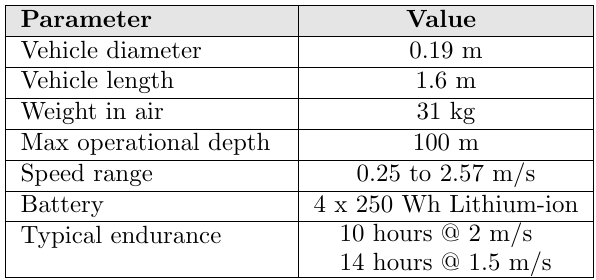
Table 1: The NTNU REMUS